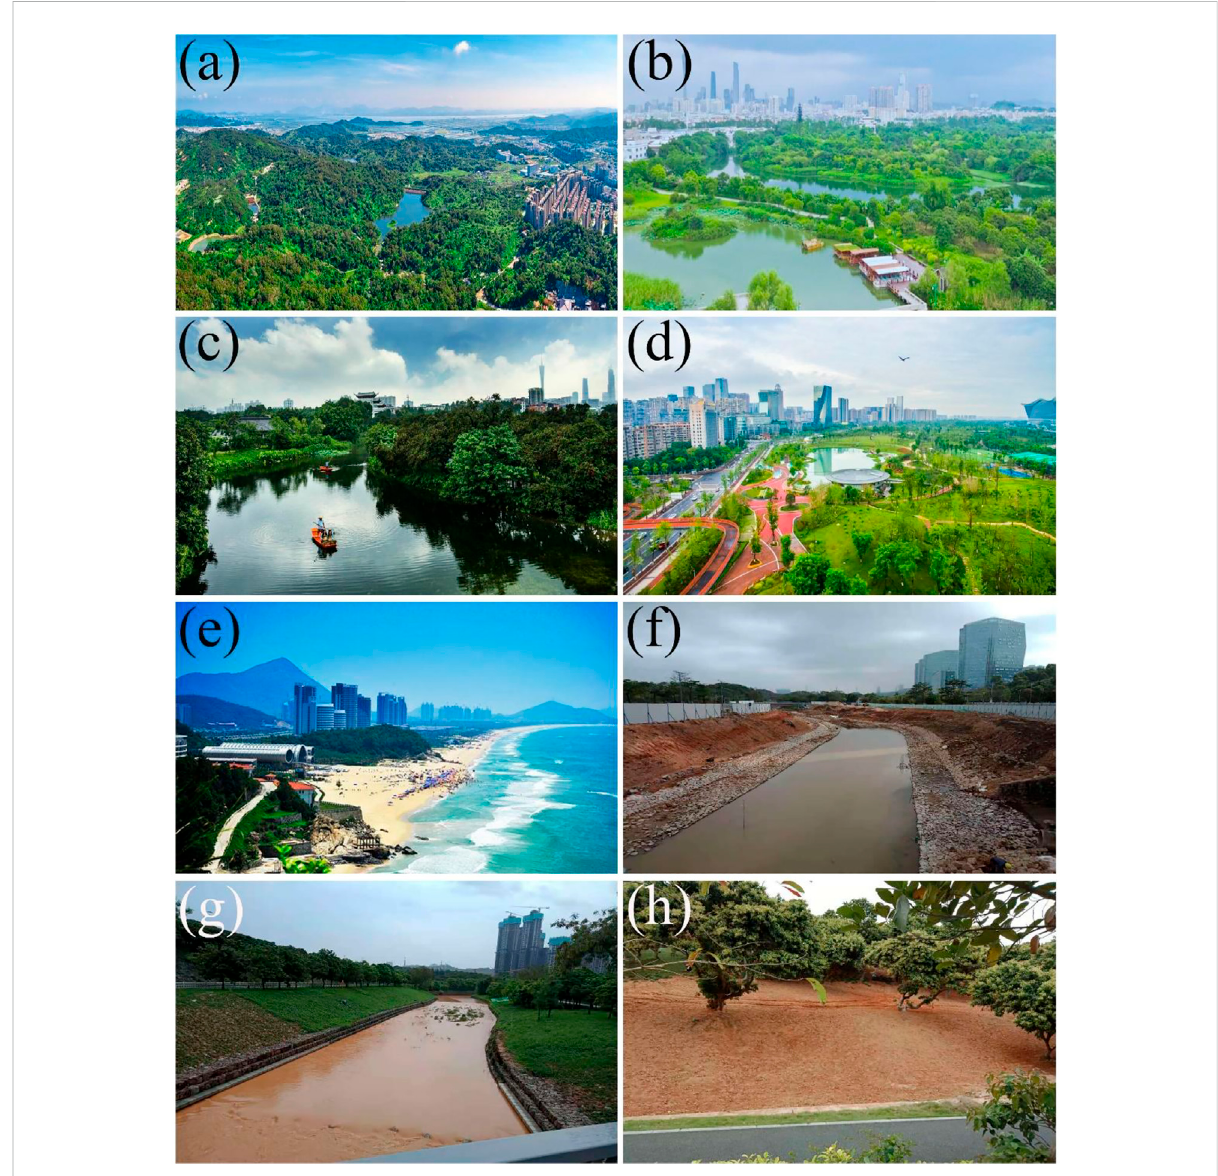
FIGURE 9 (A – D) Pictures of urban landscape compositions coordinating blue and green infrastructures (i.e., wetlands, rivers, lakes, woodlands, and grasslands) and urban development, (E) coastal exploitation, and (F – H) inappropriate urban landscape and catchment management projects that damagesurfacevegetationcoverandexacerbatesoillossandwaterpollution. (AandB) , (CandD) ,and (E) arefromtheHaizhuandLiwandistrictsof Guangzhou city and Jieyang city of Guangdong province, respectively. (F and H) Are from the Nanshan District of Shenzhen city, Guangdong